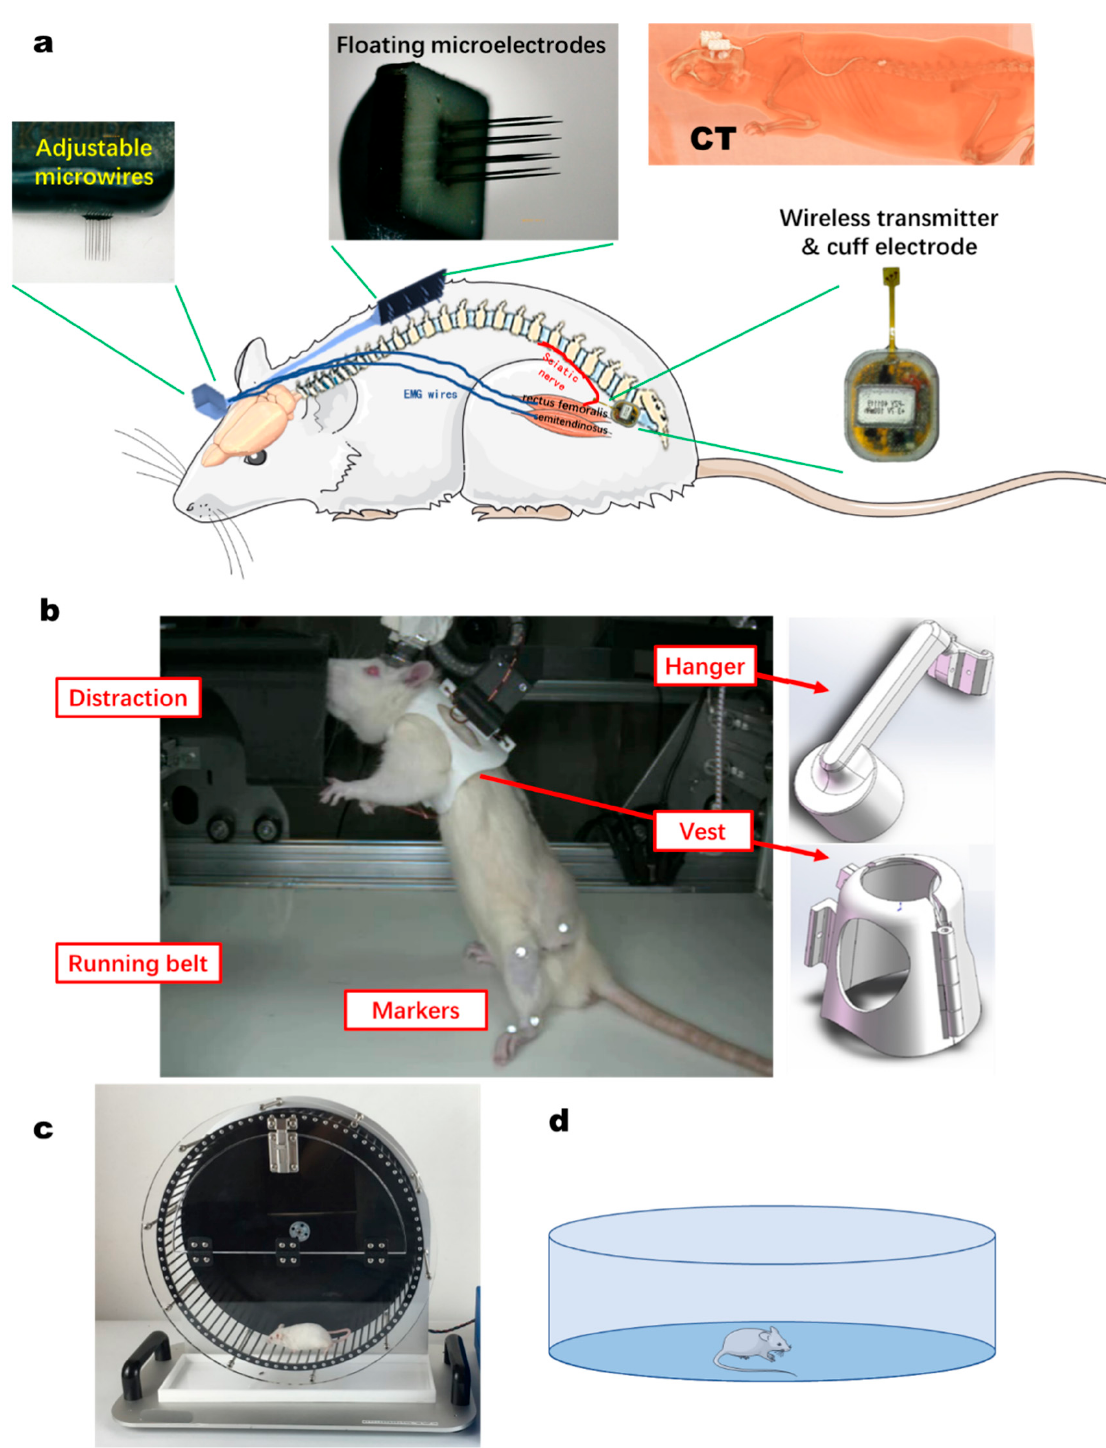
Figure 2. Positioning of implanted electrodes and experimental setups. ( a ) Schematic diagram of implanted electrode and wireless transmitter position. The motor cortex recording electrode adopted an adjustable microwire electrode (2 × 8-channel). Spinal cord signals were recorded by a floating multichannel electrode array (fMEA, 2 × 4 channels). Paired coated microwires recorded EMG signals inserted into the rectus femoris and semitendinosus muscles. The sciatic nerve signals were collected by a self-developed wireless transmitter. Upper right: CT imaging of position of electrodes. ( b ) Home-made treadmill. The rat treadmill system consists of a treadmill belt, suspension system, and control system. A cylinder was placed in front of the animal to distract the animal. With pasted markers, the joints’ coordinates were recorded by high-speed videos. ( c ) Running wheel. ( d ) Open field chamber.